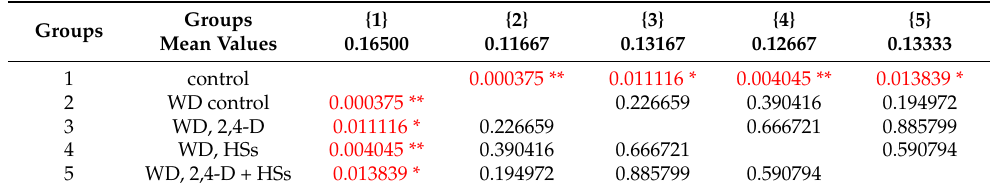
Figure 2. Mass of shoots ( a ) and roots ( b ) of wheat plants 14 days after treatment with Pseudomonas plecoglossicida 2,4 ‐ D (2,4 ‐ D), humic substances (HSs) and their combinations (2,4 ‐ D + HSs) under well ‐ watering (WW) and in water deficit (WD) conditions. Statistically different means are marked with different letters, p ≤ 0.05, n = 15 (ANOVA followed by Duncan’s test). Table 3. ANOVA test for shoot mass followed by Duncan test. Values in the cells correspond to p for the difference between the mean values; p ≤ 0.05 is marked with *; p ≤ 0.01—with ** for control plants untreated with either bacteria or HSs and plants grown under water deficit (WD): control, plants treated with Pseudomonas plecoglossicida 2,4 ‐ D (2,4 ‐ D), humic substances (HSs) and their combinations (2,4 ‐ D + HSs).